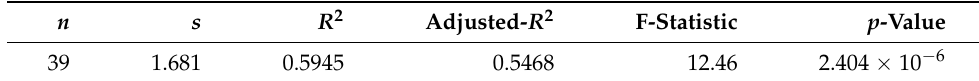
Table 6. Hydro power model